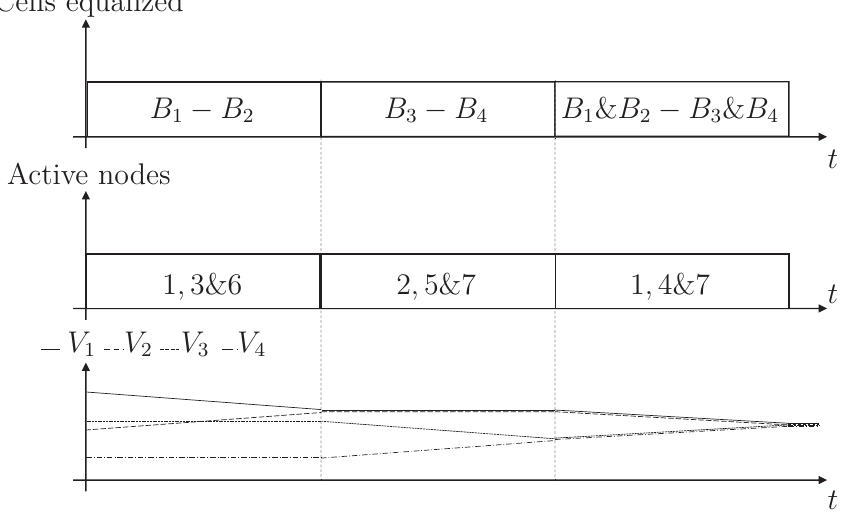
Figure 7. Operation of the proposed